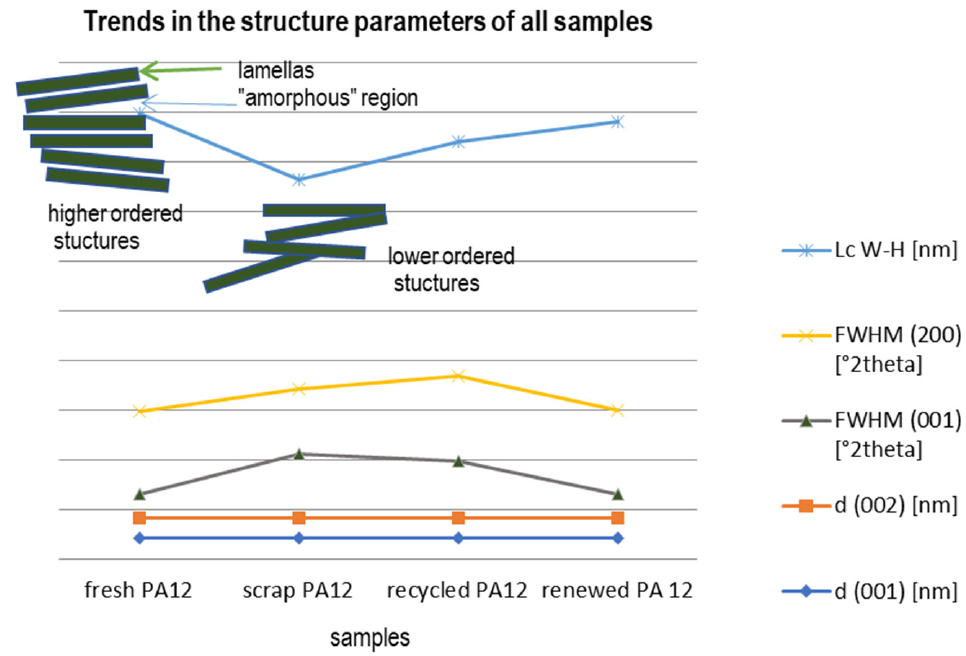
Figure 6. Charts explaining the tendency of selected calculated and measured parameters of material structure of samples with demonstration of lamellar structure ordering of PA12 regarding mean crystallite size Lc.